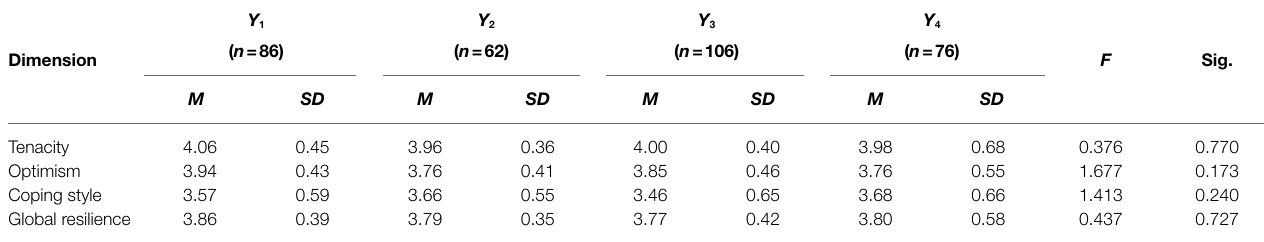
TABLE 5 | One-way ANOVA of EFL teacher resilience on years of teaching experience. Y Dimension